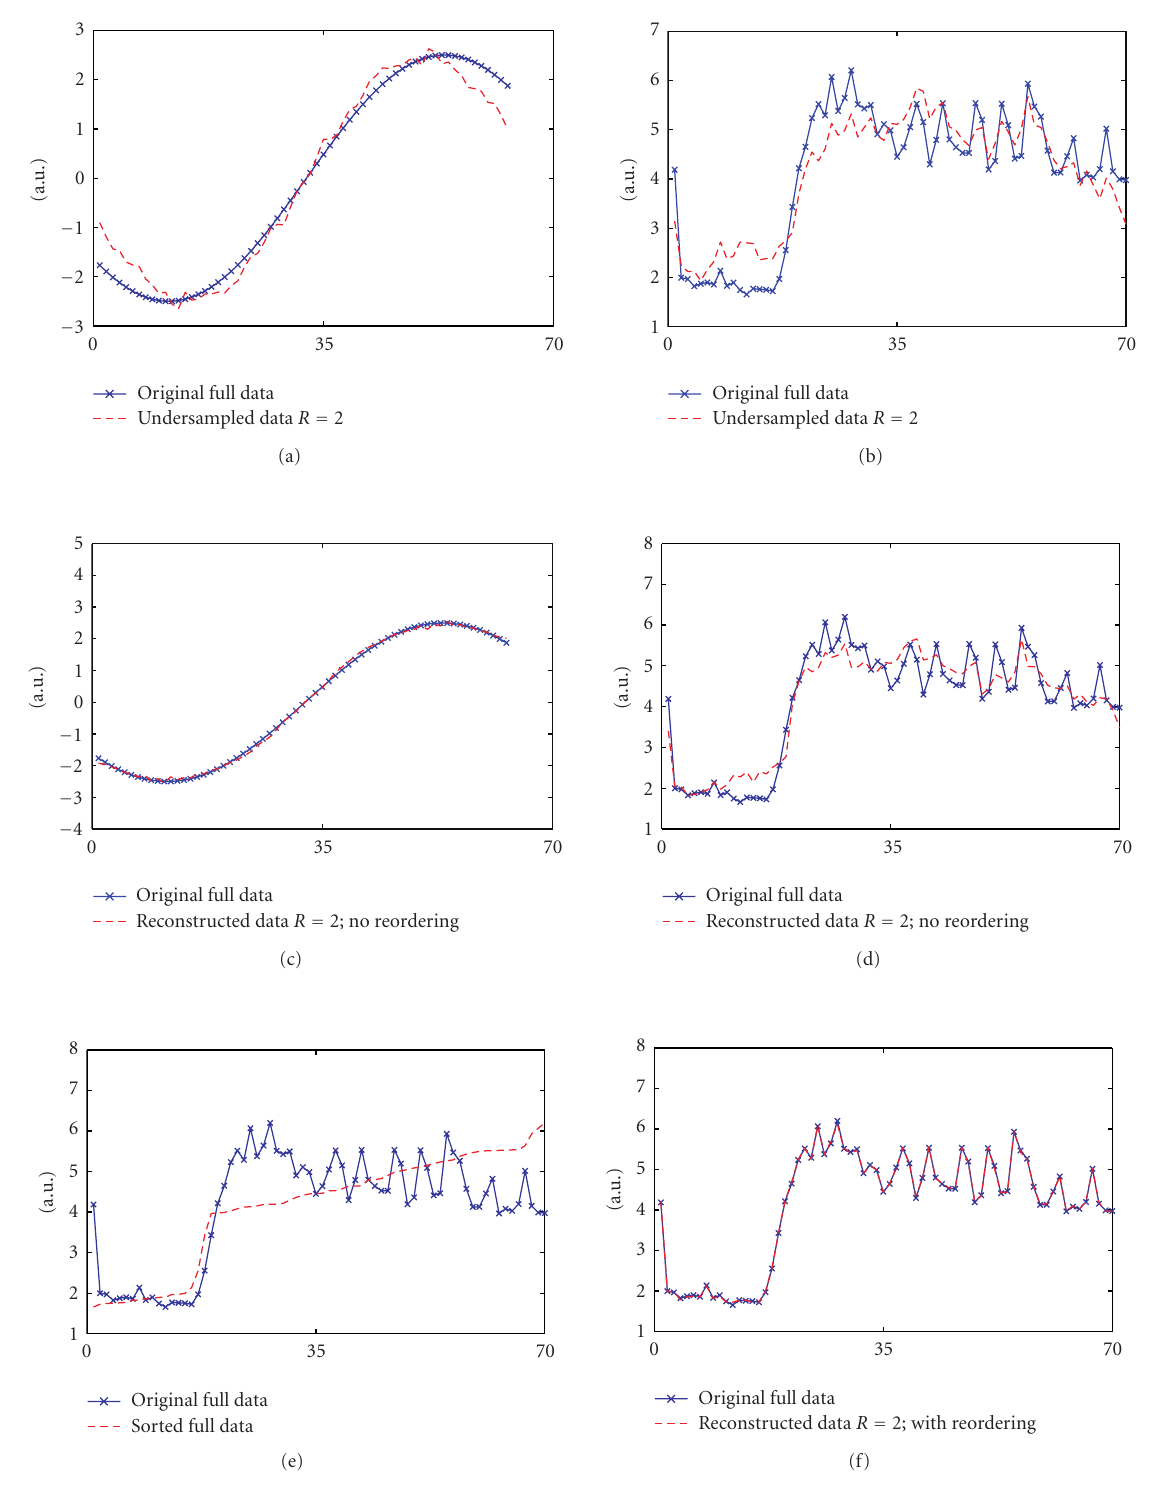
Figure 1: (a) A fully sampled smoothly varying 1D signal and the corresponding signal reconstructed using IFT from its incomplete Fourier data undersampled by a factor of two ( R ∼ 2) in a random fashion. (b) A fully sampled nonsmooth varying 1D signal and the corresponding signal reconstructed using IFT from its R ∼ 2 Fourier data undersampled in a random fashion. (c) Comparison of the original fully sampled smooth signal and the reconstructed signal from R ∼ 2 Fourier data without reordering. (d) Comparison of the original fully sampled nonsmooth signal and the corresponding signal reconstructed from R ∼ 2 Fourier data without reordering. (e) Comparison of the original fully sampled nonsmooth signal and the corresponding sorted signal. (f) Comparison of the original fully sampled nonsmooth signal and the signal reconstructed from R ∼ 2 Fourier data with